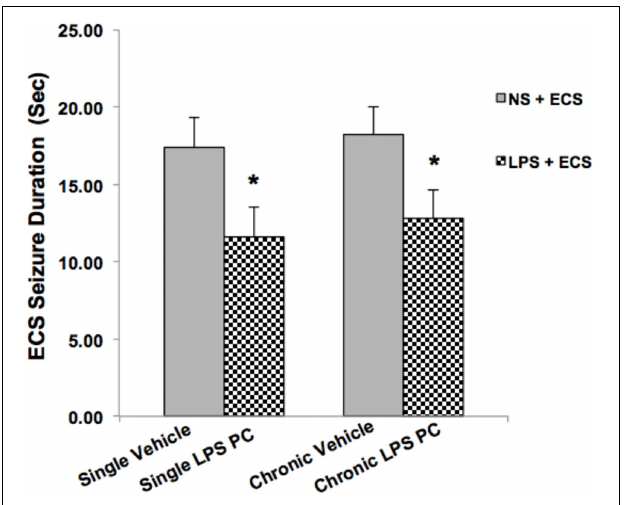
FIGURE 2 | Effect of preconditioning by single low dose and chronic ultra-low dose of LPS on seizure duration induced by ECS administration in a rat model. Asterisk ( ∗ ) denotes a significant difference between the preconditioned groups and vehicle groups. Statistical analysis was done according to Student’s t -test with significance levels of ∗ ρ < 0.05 vs. the vehicle groups. Data are shown as mean ± SEM of 12 animals ( n = 12). ECS, electroconvulsive shock; NS, normal saline; LPS, lipopolysaccharide; PC,